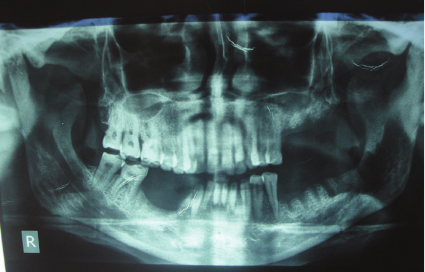
Figure3:Orthopantomogram(OPG)revealedill-definedosteolytic region involving body and ascending ramus of mandible.